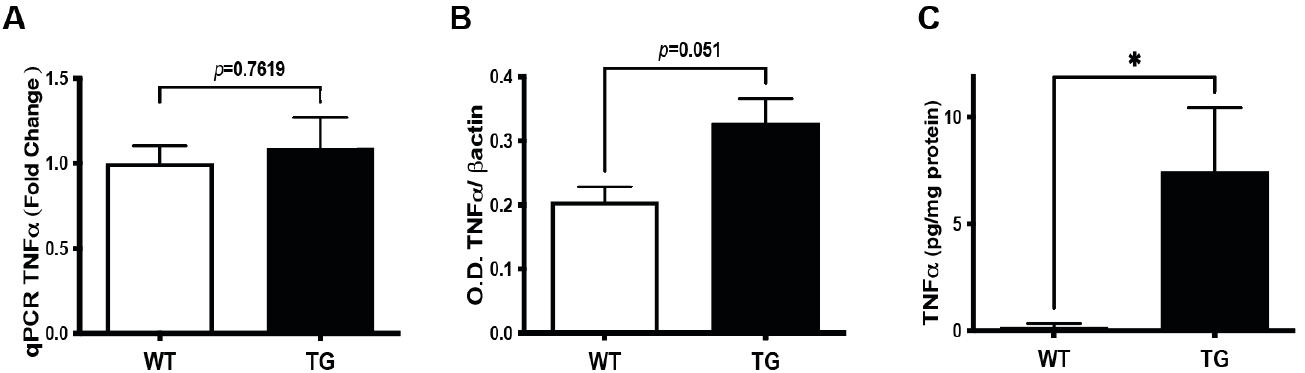
Figure 4. TNF α expression in pre-symptomatic APP/PS1 retina. ( A ) Transcriptional analysis by